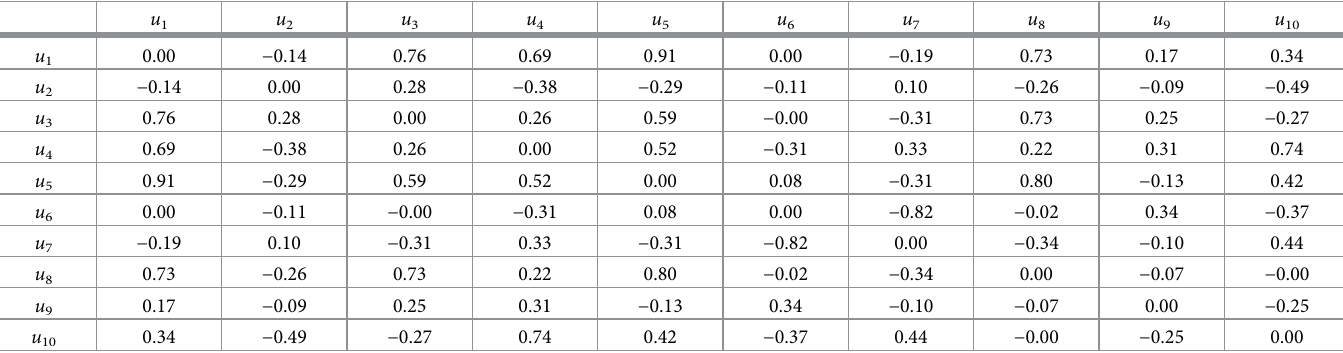
as shown in Table 10. Average aggregation strategy is applied on predicted ratings to generate Top-k recommendations, as shown in Table 11.